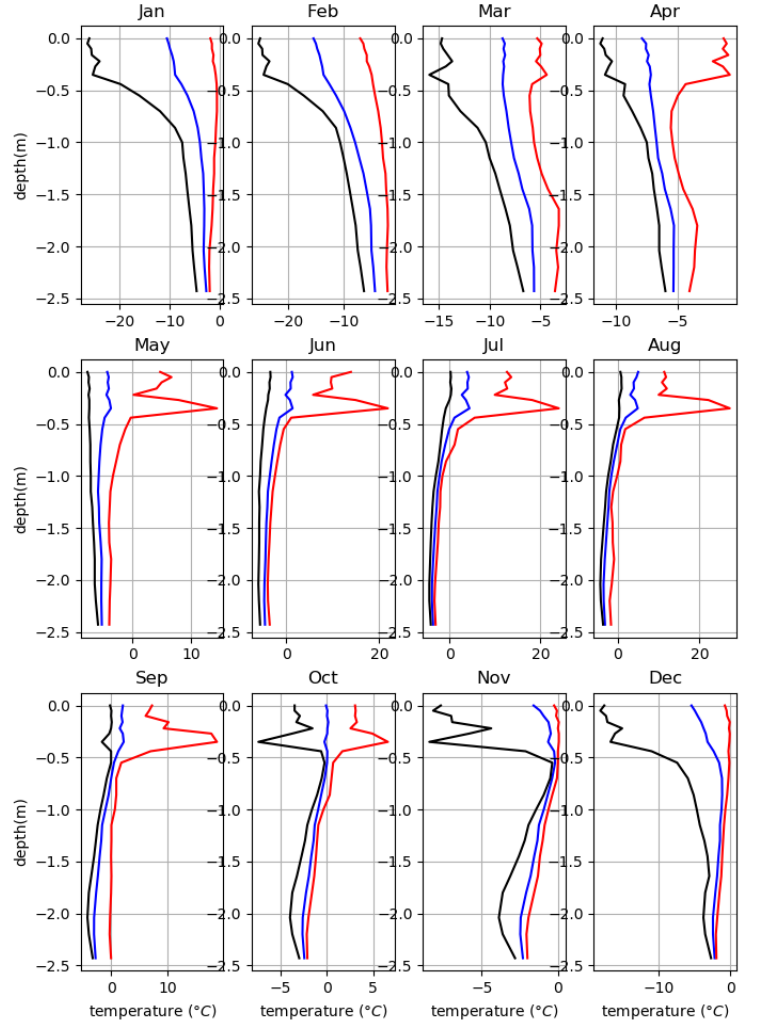
Figure A6. Trumpet curves of the temperature within bluffs for each